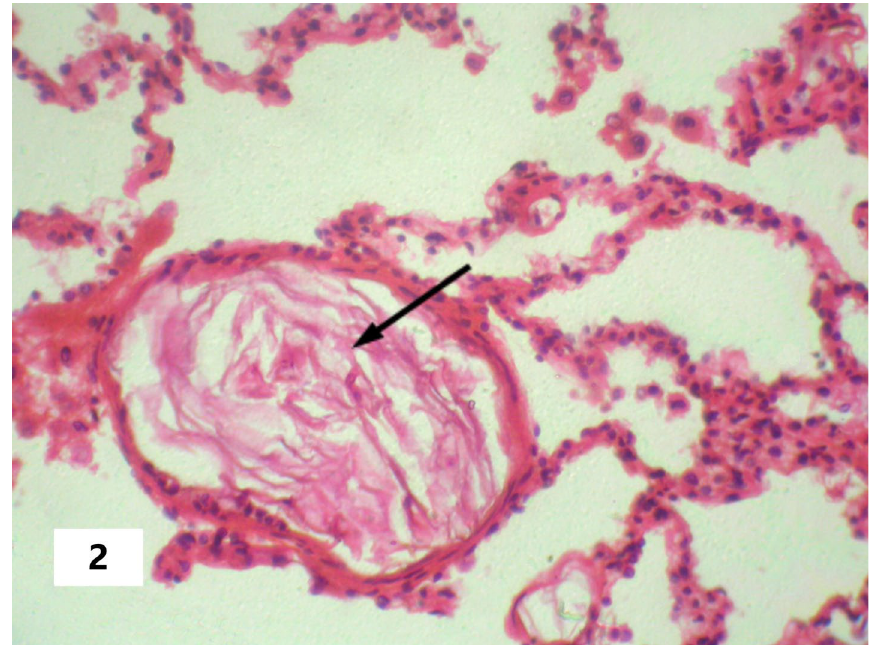
Figure 2. Fetal squamous cells in the maternal pulmonary microcirculation. The arrow indicates fetal squamous cells in the vessel lumen (Hematoxylin and Eosin stain, ×100 magnification).